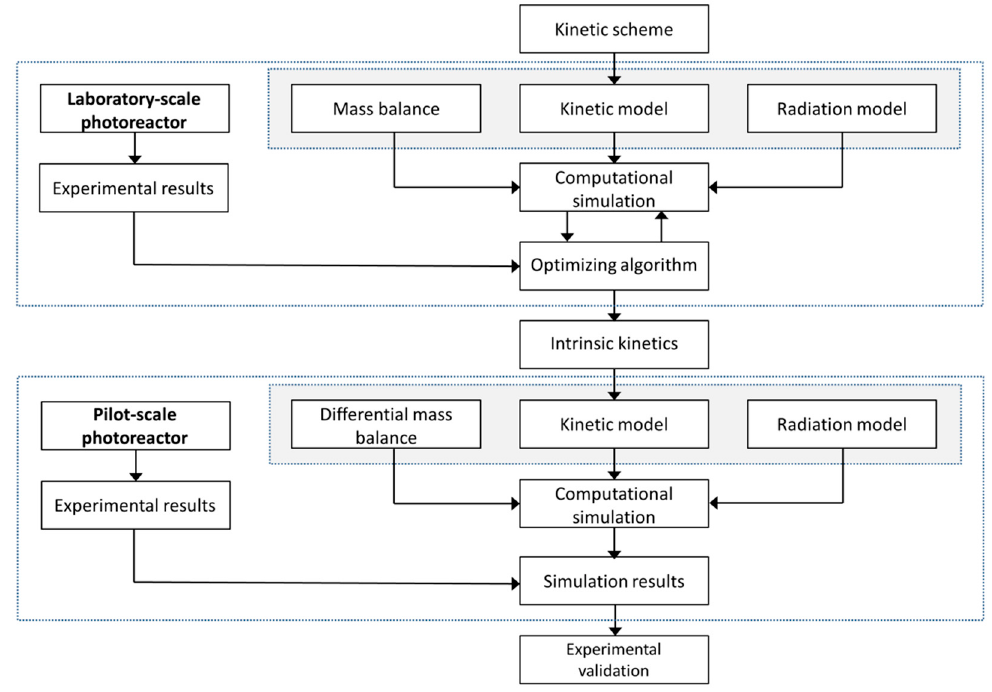
Figure 1. Flow chart of the scaling-up methodology of photocatalytic reactors. Adopted with permission from [61]. Copyright Elsevier, 2007.